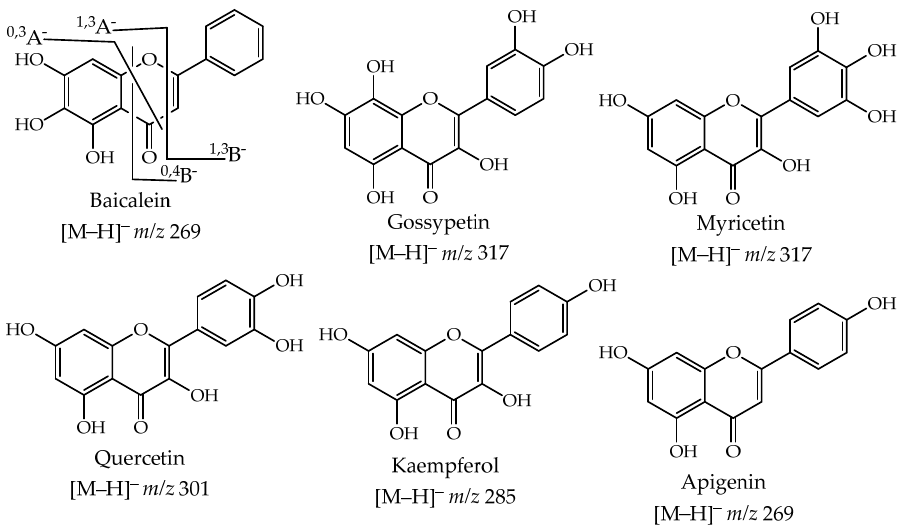
Figure 5. Chemical structure of the flavonoid aglycones and their most significant fragments.